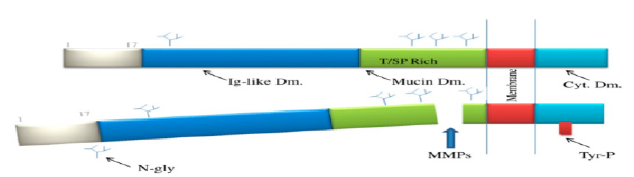
Figure 1. Kidney injury molecule-1 structure. Immunoglobulin-like domain (Ig-like Dm), N-glycosylation sites (N-gly), mucin domain (Mucin Dm), metalloproteinase (MMPs), cytoplasmic domain (Cyt Dm), and P–tyrosine (Tyr–P) site .